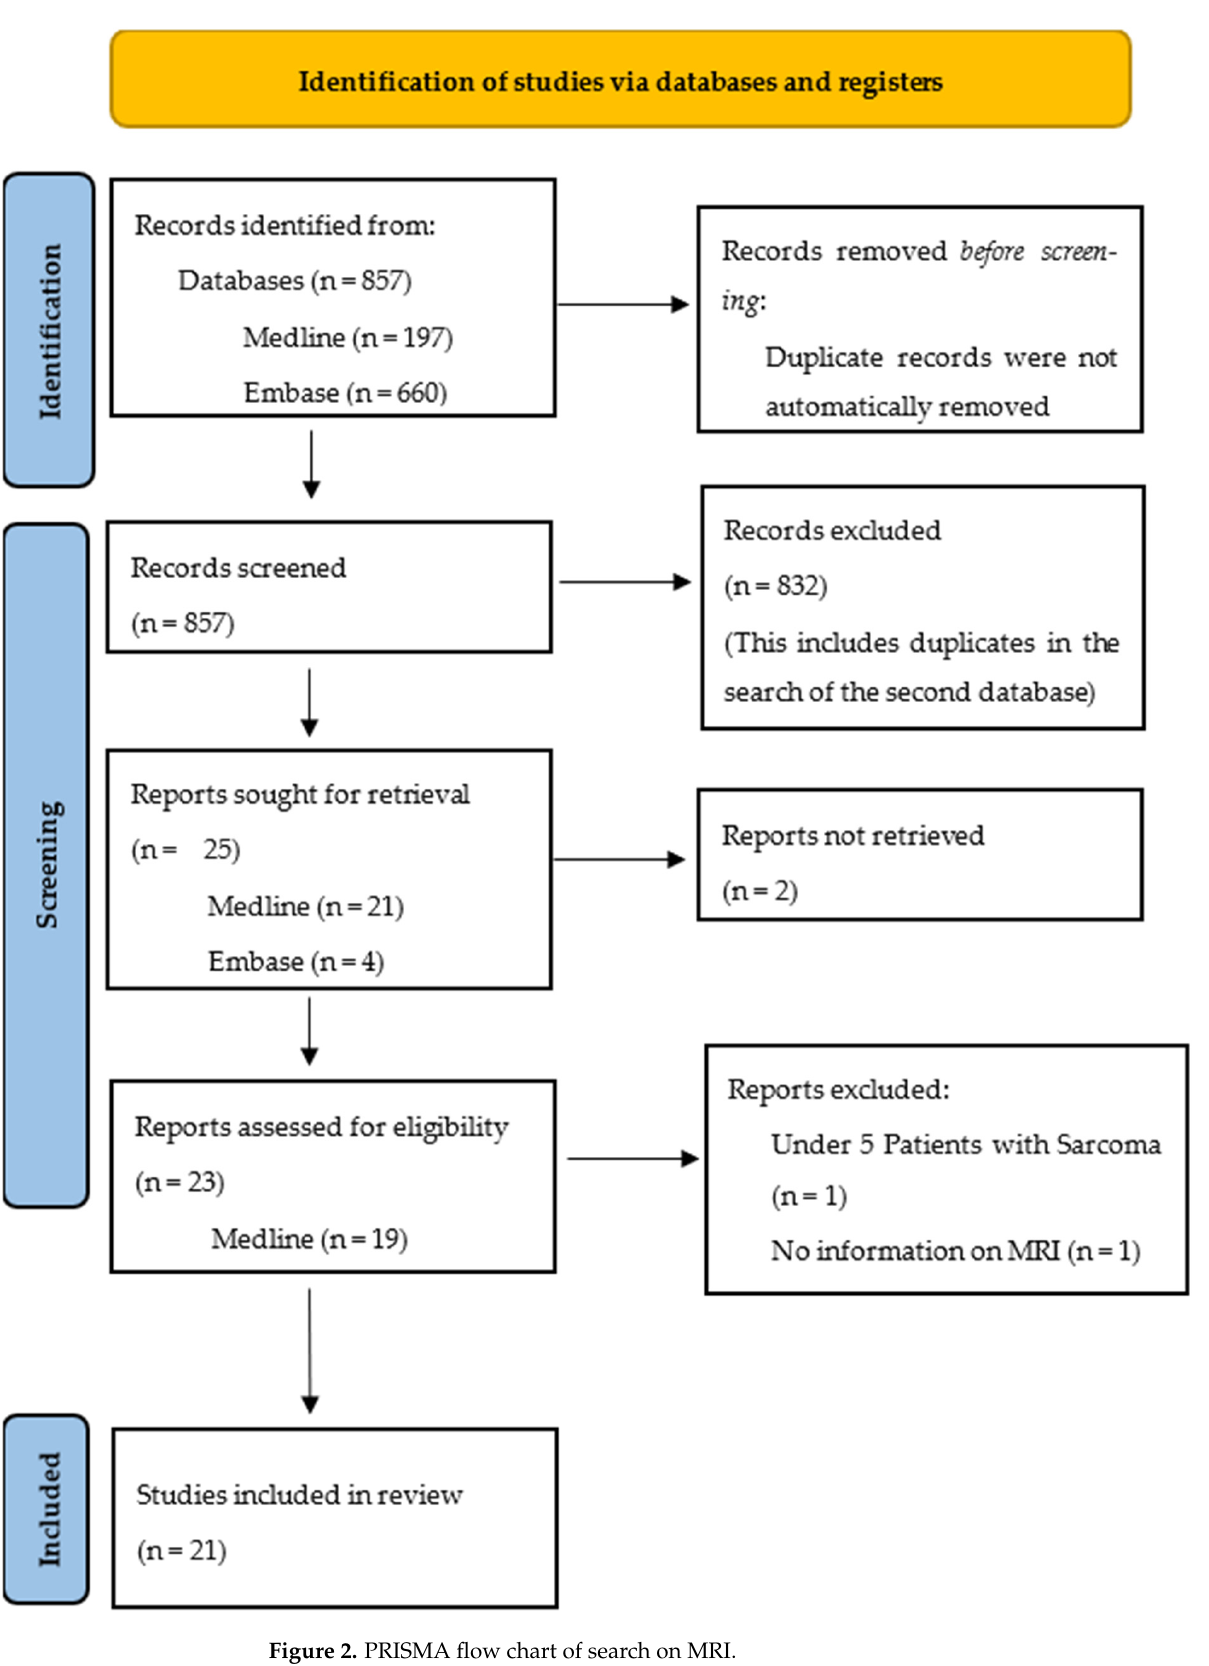
Figure 2. PRISMA flow chart of search on MRI.